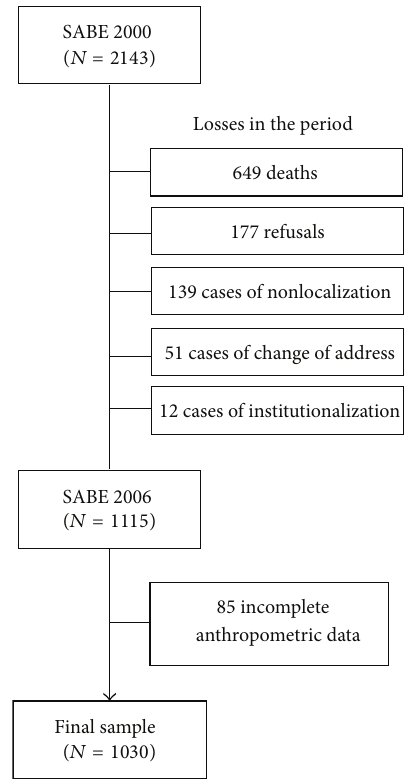
Figure 1: Final sample of older adults according to changes that occurred in the period, SABE Survey,